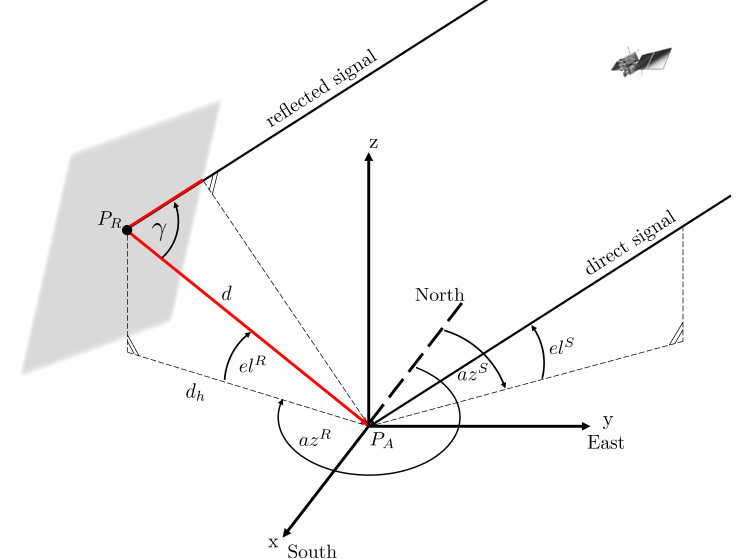
Figure 2. Geometrical satellite-reflector-antenna configuration for a single reflector with arbitrary orientation in